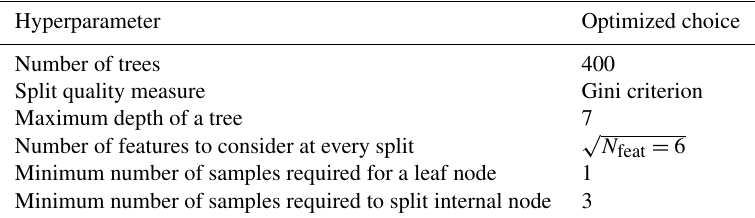
Table B2. Hyperparameters of final random forest